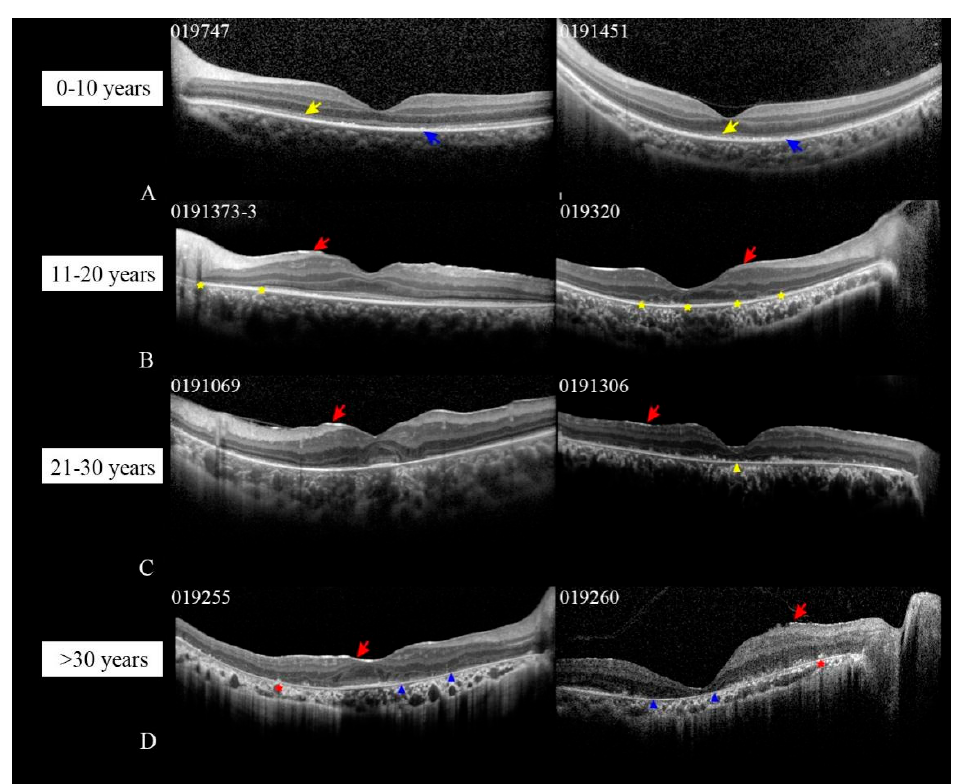
Figure 5. Spectral domain OCT scans in patients with RPE65-IRDs. ( A ) OCT scans of patients 019747 and 0191451 in group 1 (age 0–10 years) show a coarse ellipsoid zone (EZ; yellow arrow) and hyperreflective remnants in the retinal pigment epithelium (RPE; blue arrows). ( B ) OCT scans of patients 0191373-3 and 019320 in group 2 (age 11–20 years) showed a distorted inner retinal architecture with a disruption and absence of the EZ in the foveal and parafoveal regions, respectively (yellow asterisk). ( C ) OCT scans of the patients in group 3 (age 21–30 years) exhibited distorted retinal architectures (0191069), atrophy in the fovea (yellow triangle), and disruption of the EZ. ( D ) OCT images of patients in group 4 (age > 30 years) revealed a disorganized macular structure with destruction of the IS/OS and RPE (blue triangle) and hyperreflective depositions in the outer retina (red asterisk). Epiretinal member (red arrow) presented in all patients from groups 2–4.